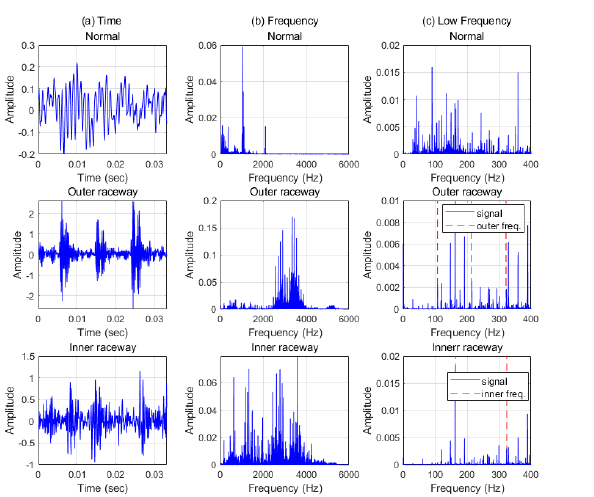
Figure 5. CWRU data with load 0 hp and 0.007 defect in ( a ) time, ( b ) frequency, and ( c ) low frequency. The red dash lines are the characteristic frequencies and their harmonics. BPFO = 107.3 Hz, BPFI = 162.09